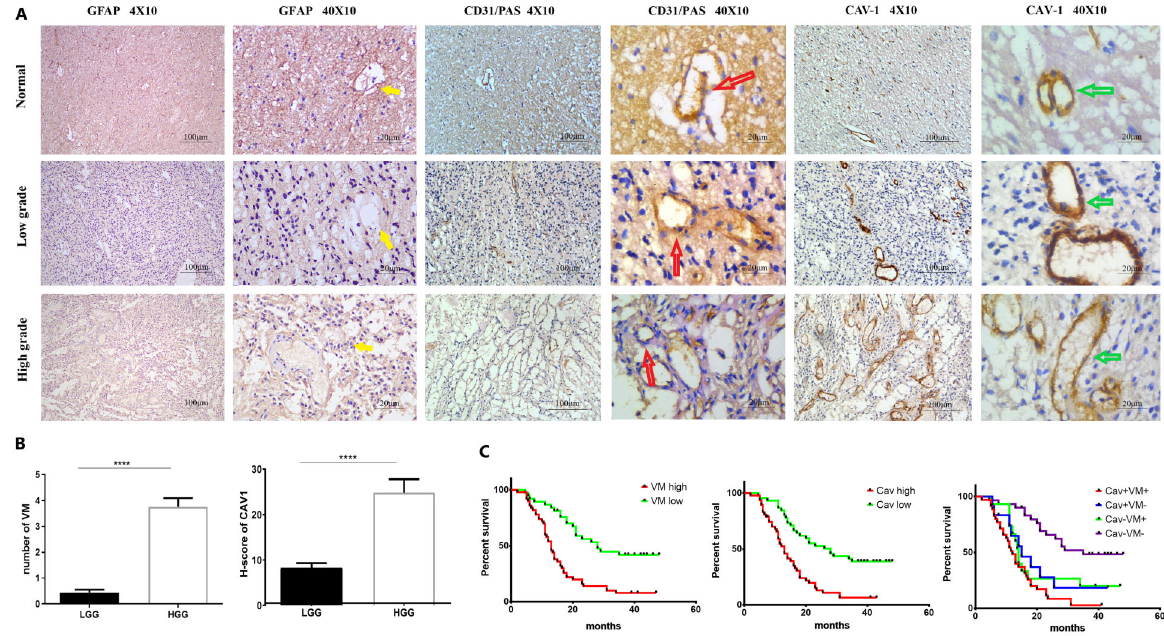
Figure 1. Correlation of Cav-1 expression and/or vasculogenic mimicry (VM) formation with human glioma grades and overall survival of glioma patients. A , Immunohistochemical staining for GFAP (brown, yellow arrow), Cav-1 (brown, green arrow), and CD31/PAS co-staining for VM channels (light purple, red arrow) in glioma specimens. Magni fi cation 40 (cid:1) (scale bar 100 m m) and 400 (cid:1) (scale bar 20 m m). B , The mean number of VM channels (left) and Cav-1-positive tumor cells (right) in low-grade (LGG) (n=39) and high-grade gliomas (HGG) (n=55). Data are reported as means ± SE. ****P o 0.0001. C , Kaplan-Meier analyses of overall survival in all glioma patients with differential Cav-1 expression and/or VM